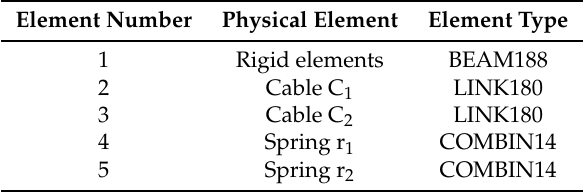
Table 4. Type of elements.